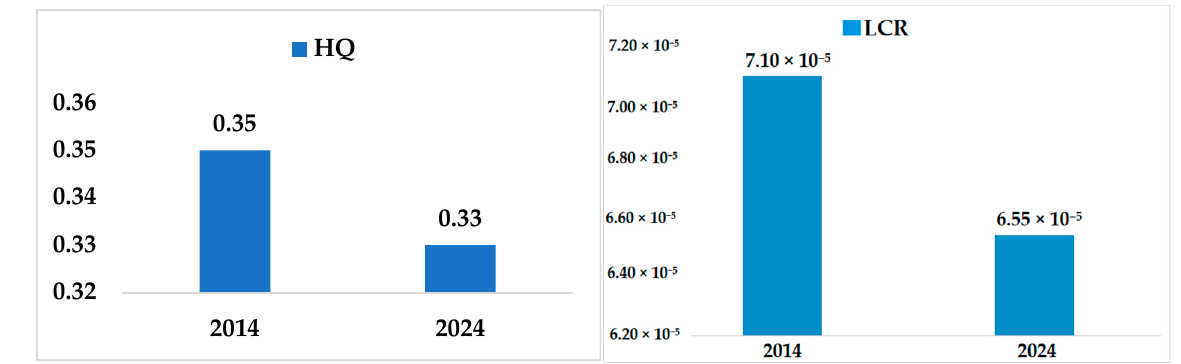
Figure 7. Predicted HQ and LCR of As ingestion via drinking water from Langat River in 2014 and for 2024, respectively.